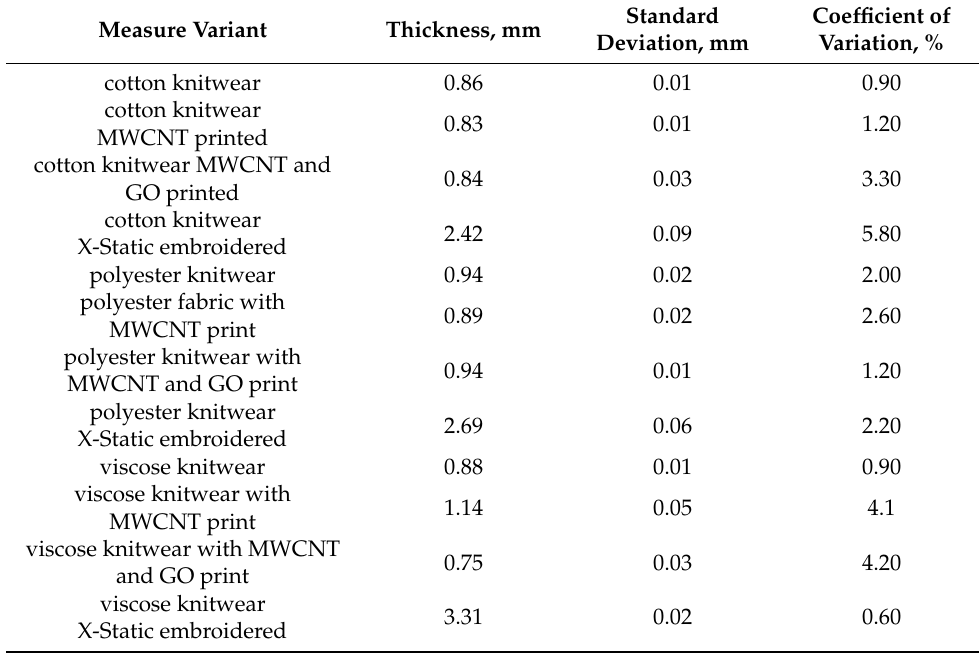
Table 3. Values of the average thickness of textiles before and after alterations.